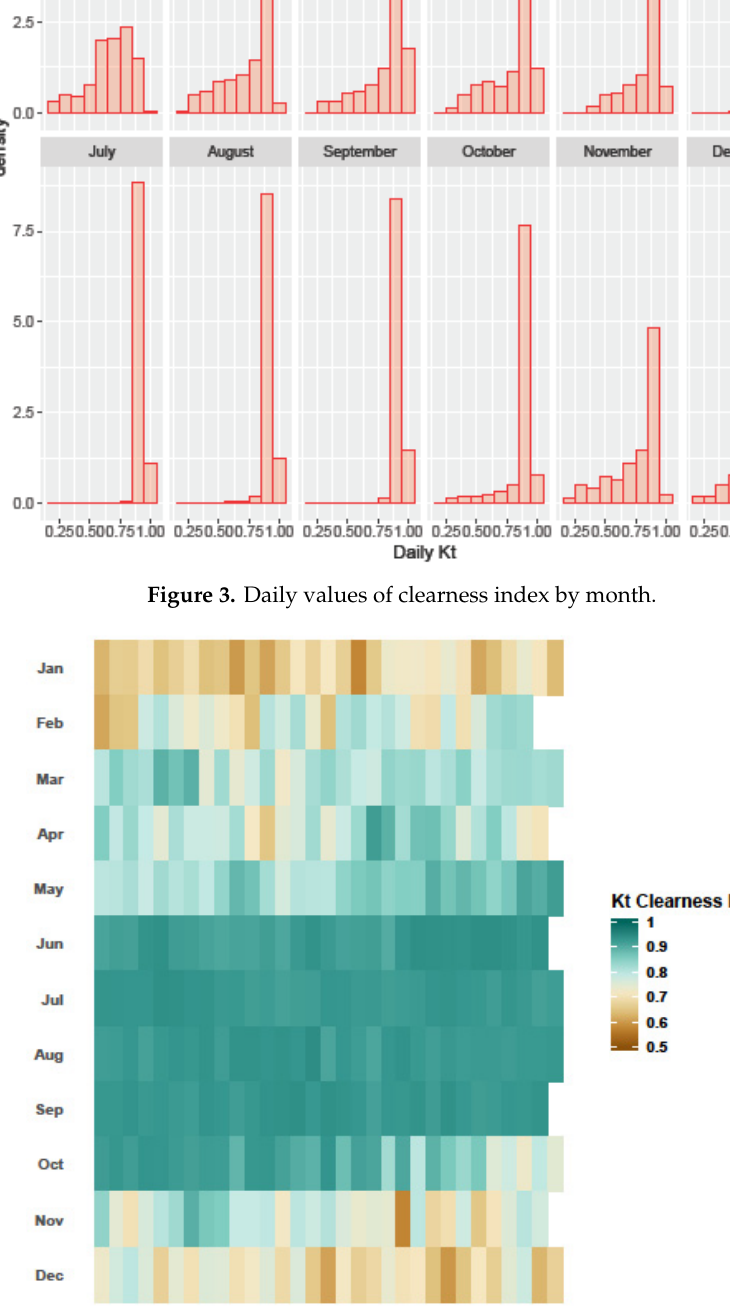
Figure 4. Mean Daily Clearness Indices ( (cid:1837) ) by day and month for the period 2005–2017. (cid:3047) Plotting the daily data by month (Figure 3) suggests that the same component distributions are more prevalent at different times of the year, reflecting seasonal weather fluctuations at the site, and the influence of latitude on solar intensity. For instance, Ref. [57] noted that winter season precipitation is useful for estimating the likely frequency of dust-storms, which would correlate with periods of lower sky clarity as appears to be the case for January, February, and December. Ref. [58] identified that poor visibility events in the UAE arise either as a result of dry, wind-induced dust storms, or wetter weather such as fog or haze. Thus, rare poor visibility events during the summer are probably related to the Haboob winds transporting dust from the east and northeast [59]. Stronger wind speeds occur the hotter months, strengthening in response to the Low Level Jet during nocturnal hours and offset from the peak GHI [60]. In contrast, the winter north and northwesterly winds bringing higher relative humidity from the Gulf of Aman impact at-site visibility while more stable, clearer, conditions occur in the summer [59], as is apparent in Figures 3 and 4. Figure 4 illustrates the daily clearness index, calculated from a time series of extra-terrestrial and received solar irradiation between 2005 and 2017. For each day, the color represents the mean value